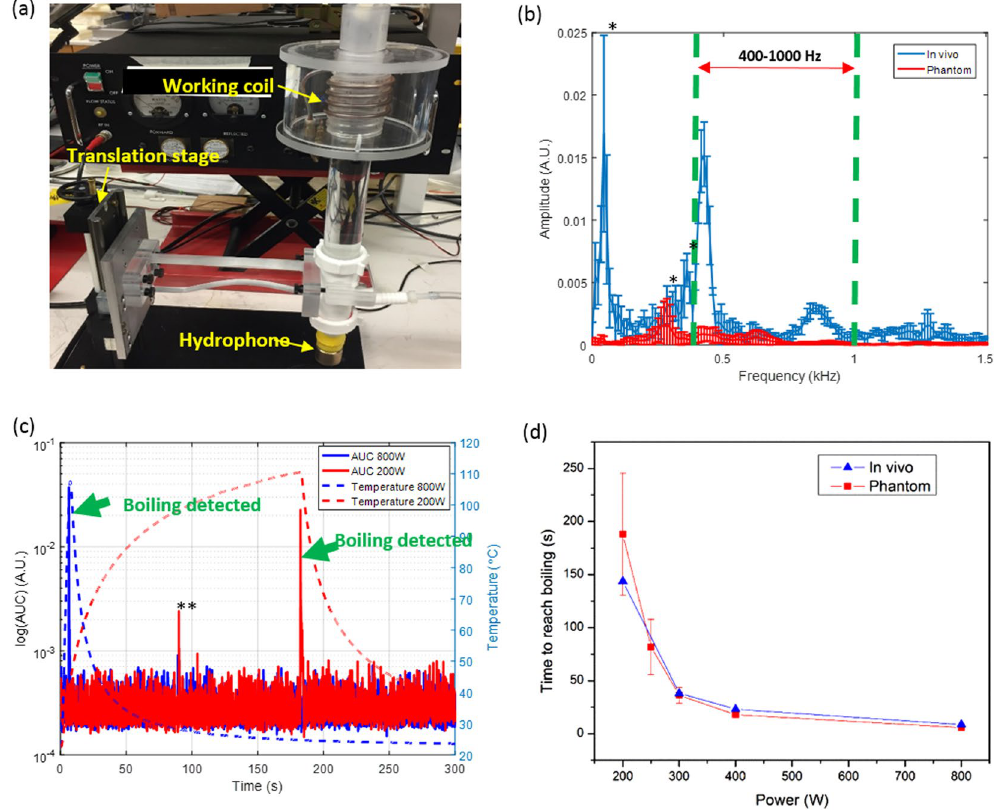
Figure 7. Boiling detection for AMF safety control. ( a ) The AMF system with boiling detection, including: working coil, hydrophone, and translation stage; ( b ) Frequency spectrum of the sound signals acquired from the hydrophone when boiling occurs both in vivo (n = 4) and in tissue-mimicking phantoms (n = 4); * : environmental noise; ( c ) Relationship between AUC and temperature of the metal implant in tissue-mimic phantoms. Both high power (800W, blue curves) and low power (200W, red curves) exposure were shown. ** : a wrench fell down on the table; ( d ) Relationship between boiling time and exposure power both in vivo and in